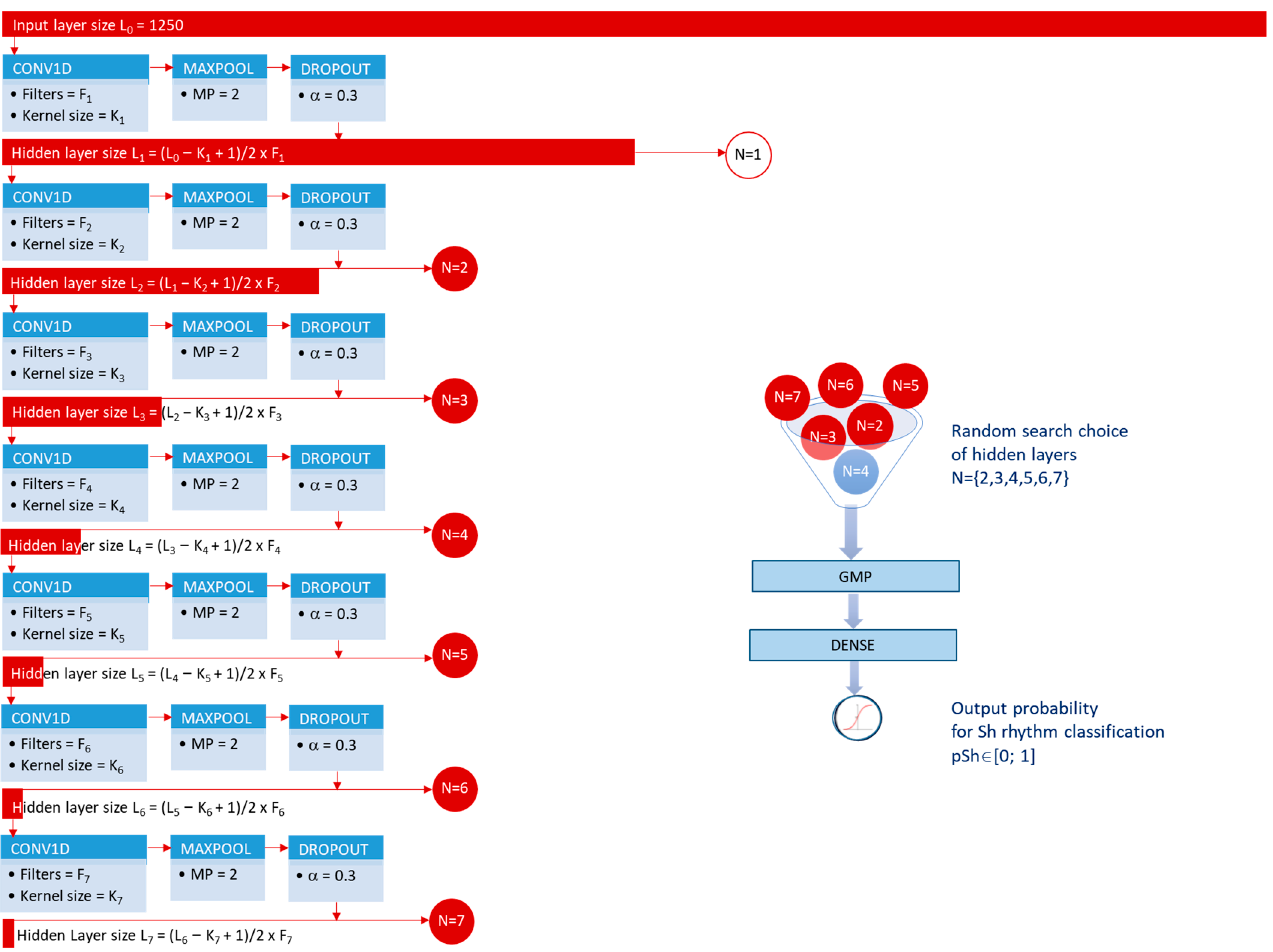
Figure 2. CNN architecture and regularization of the depth by random search selection of the hidden layer output of an arbitrary convolutional block N = {2, 3…7} for classification. The width of the red horizontal bars is scaled to represent the sizes of the input and hidden layers, illustrating the true model shrinkage from top to bottom due to MP = 2 after each convolutional block.